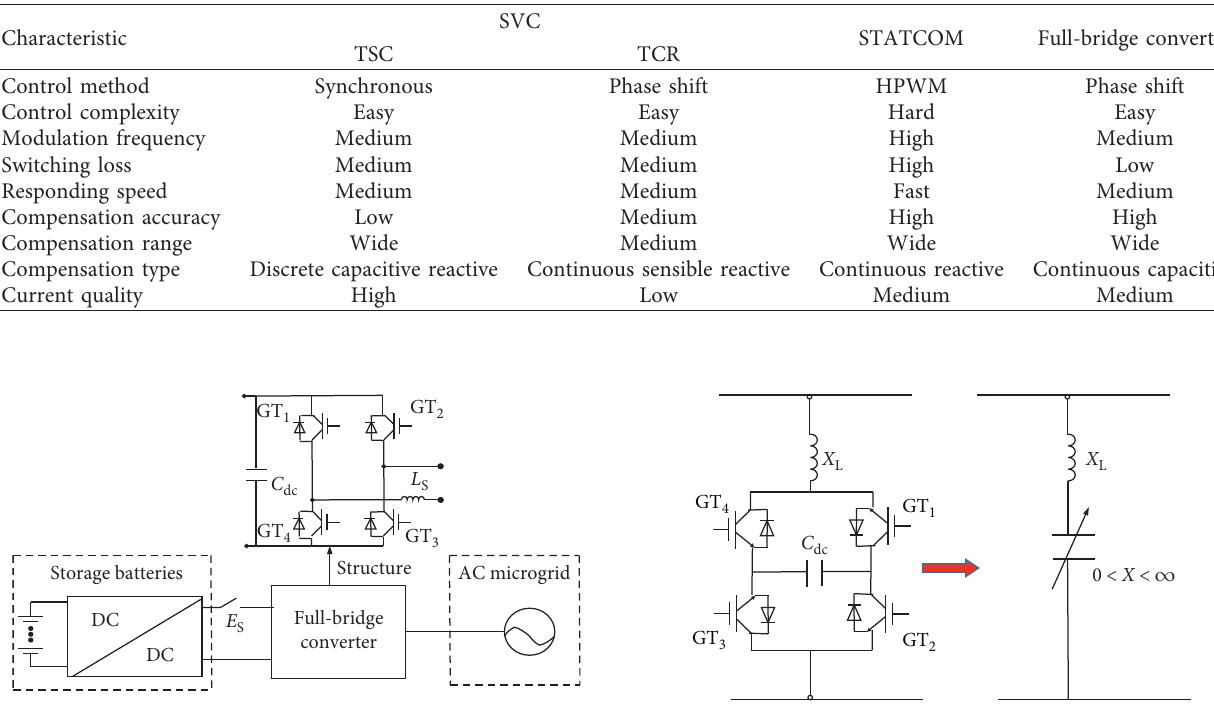
Figure 1: Full-bridge converter energy storage structure.